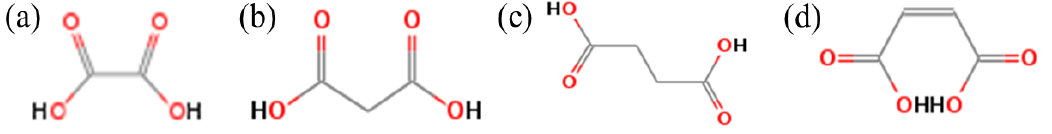
Figure 9. Molecular structural formula of ( a ) OA, ( b ) PD, ( c ) SA and ( d ) MA.